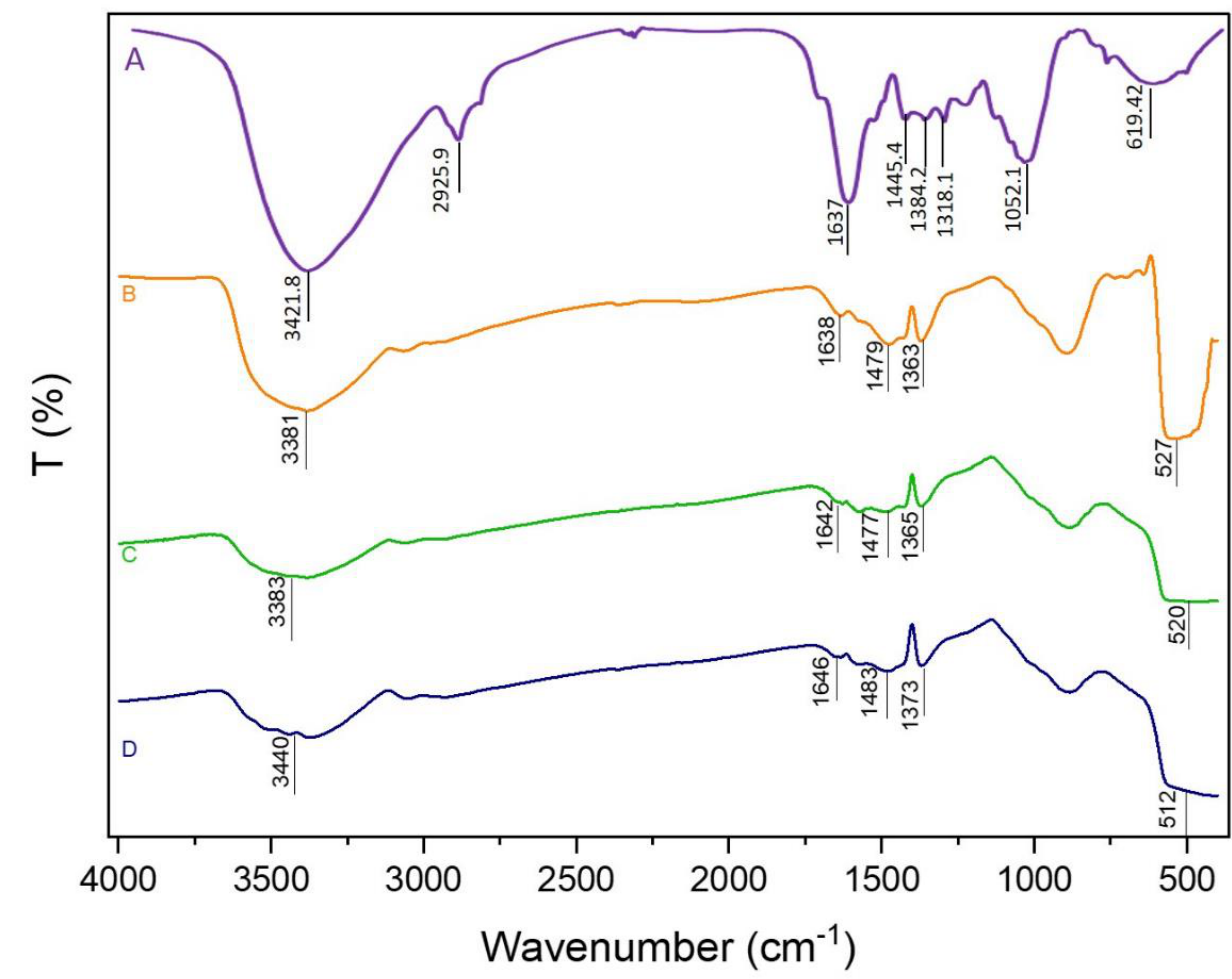
Figure 1. FT-IR spectra of Ziziphus jujuba leaves extract ( A ), T ZnO NPs ( B ), B ZnO NPs ( C ) and BMW ZnO NPs ( D ).